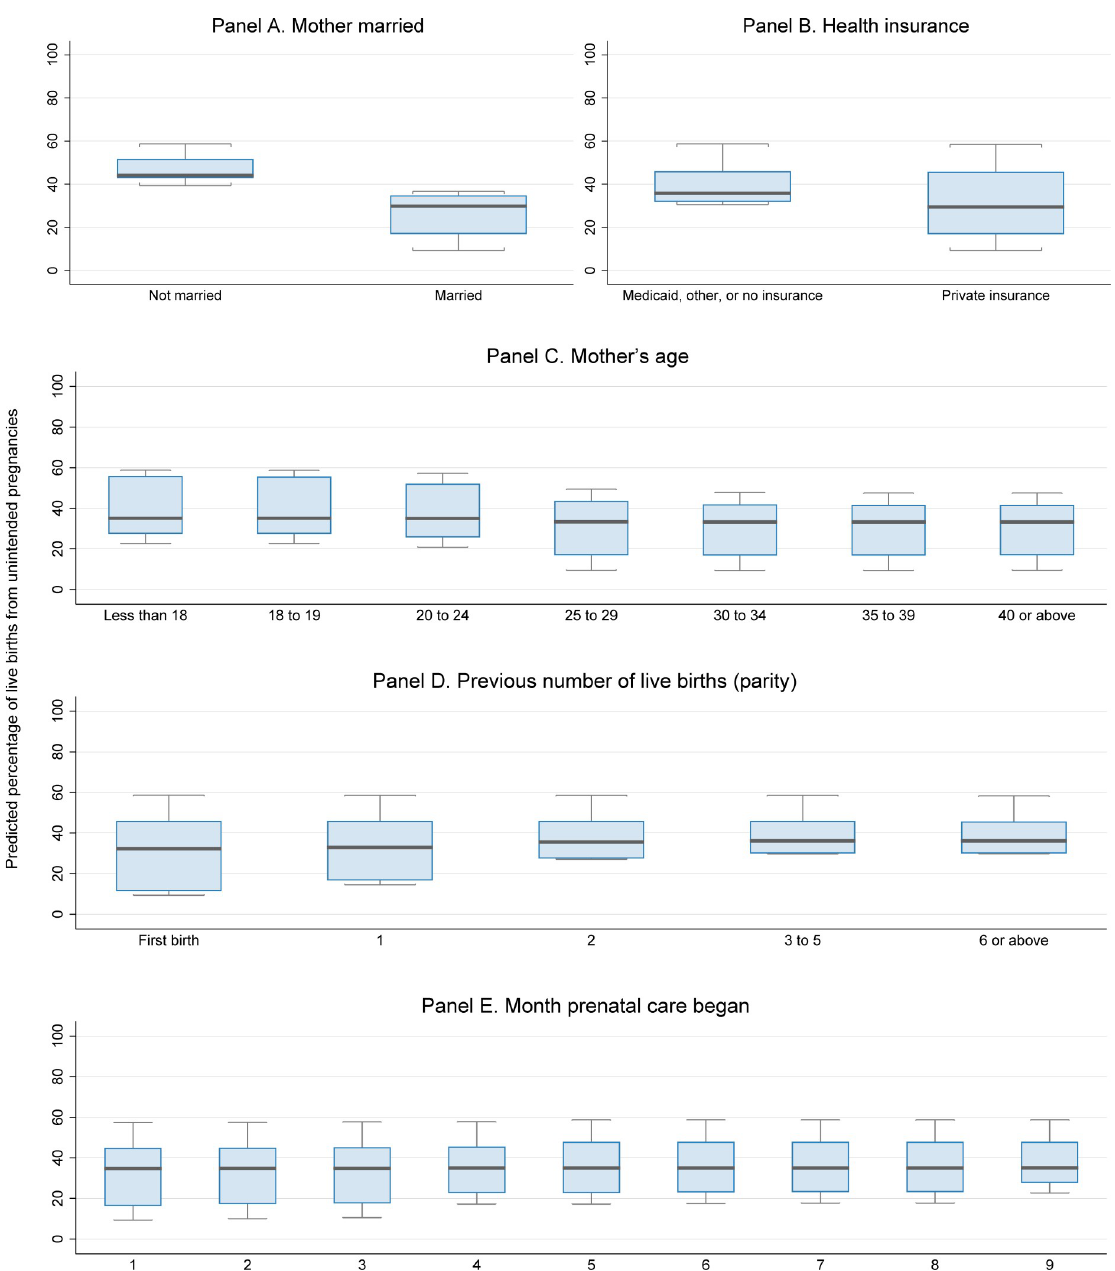
Fig 2. Estimated associations between mothers’ characteristics and the percentage of live births that resulted from unintended pregnancies.